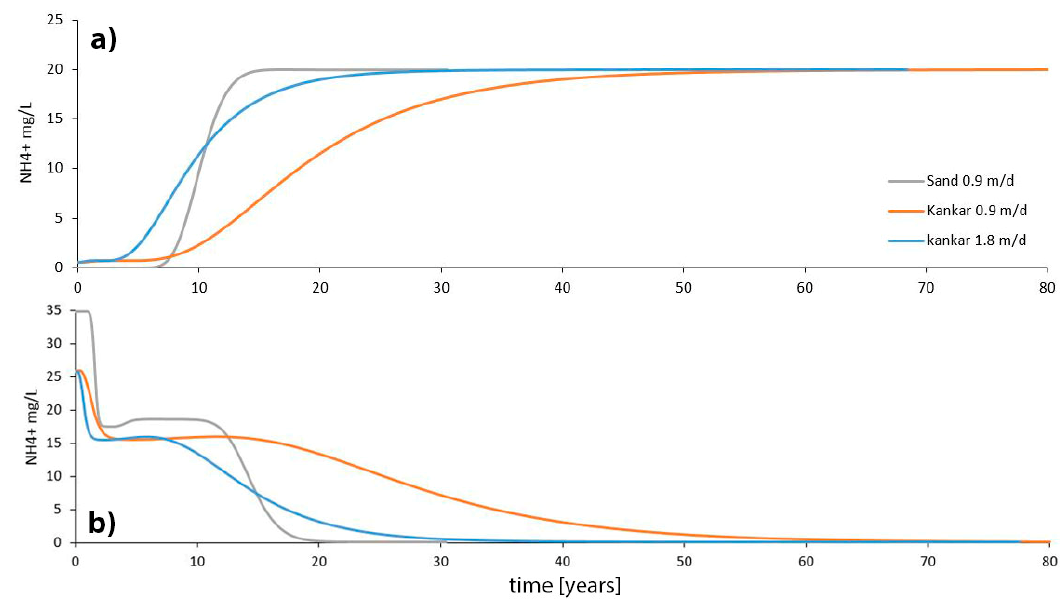
Figure 5. ( a ) Results of the adsorption modeling. ( b ) Results of the desorption modeling.